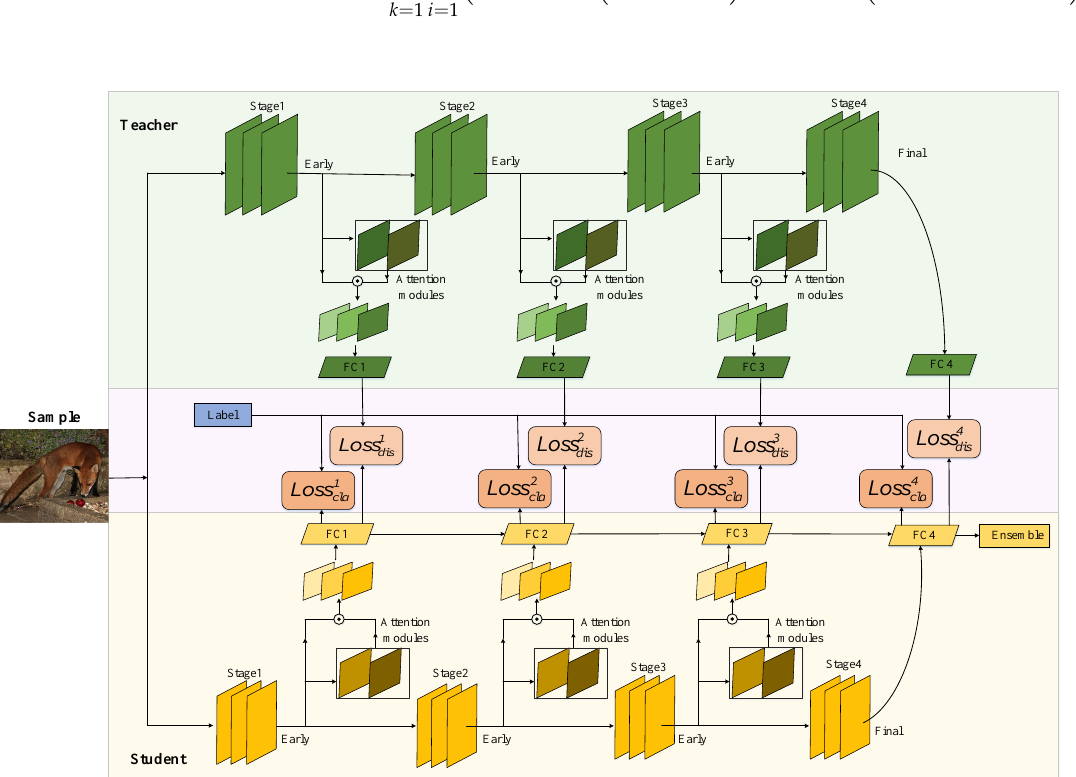
Figure 3. Overall framework of the OtO method. Each of these exits has two types of losses: a distillation loss from the branch network corresponding to the teacher network and classification loss from the true